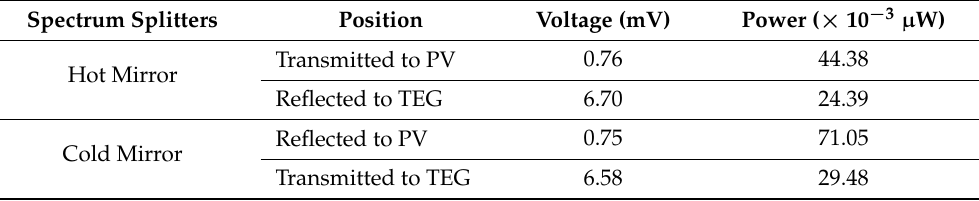
Table 3. Characteristics of PV-TEG in P = f(V) using spectrum splitters Hot and Cold